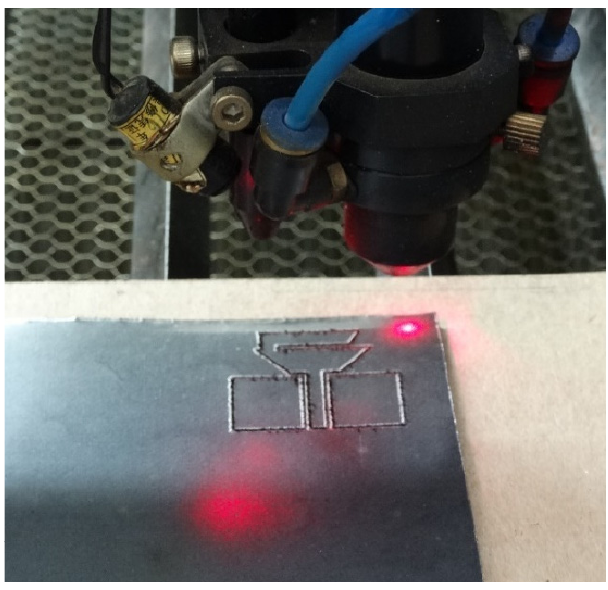
Figure 5. The process of recording the geometry of the antenna on the graphene film.